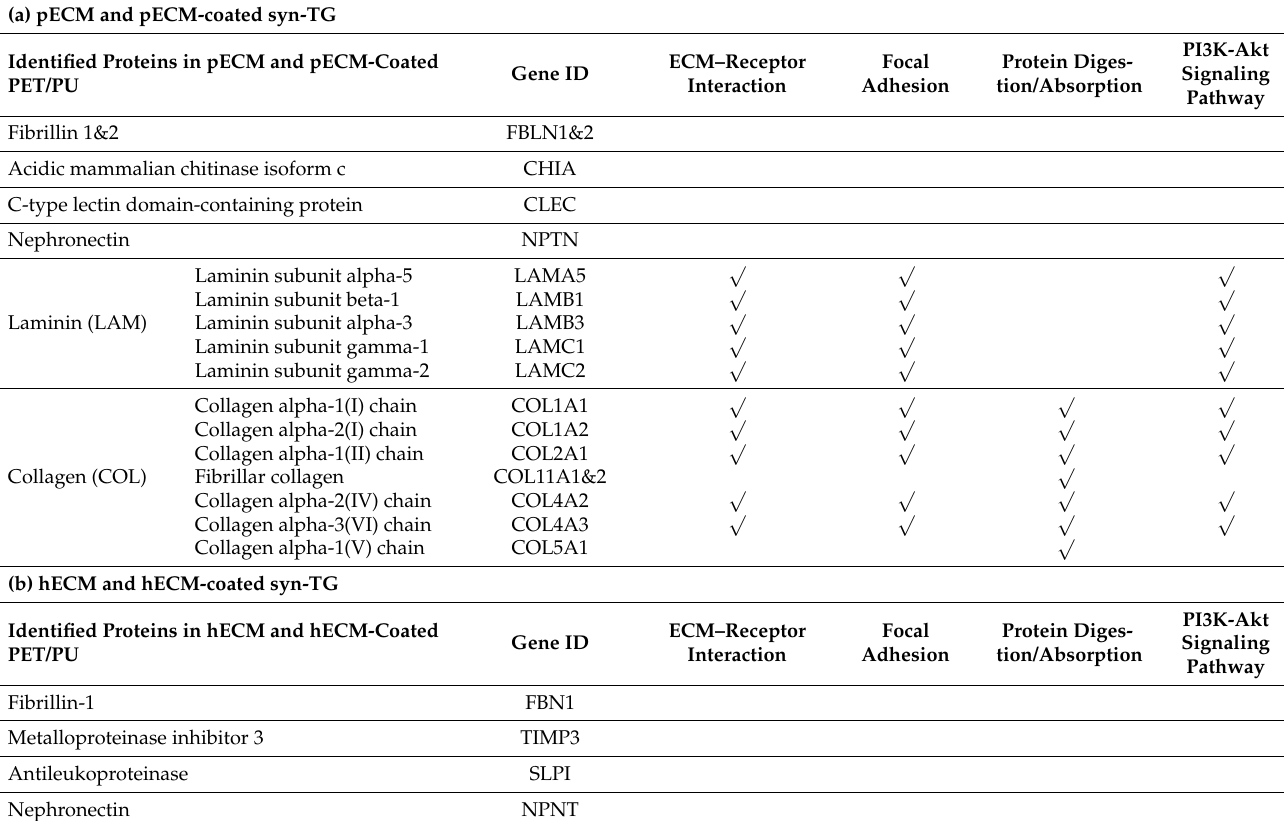
Table 1. The proteins and functional pathways identified by the protein interaction analyses in pECM and pECM-coated syn-TG and hECM and hECM-coated